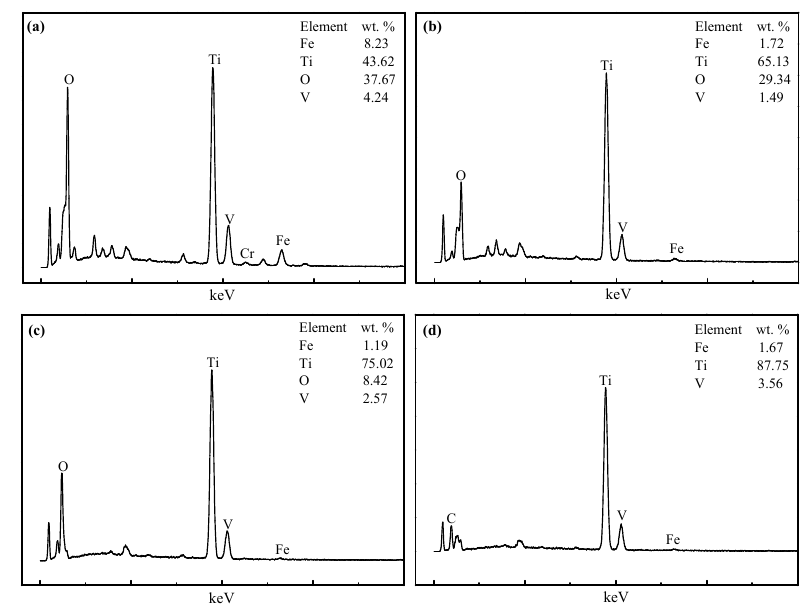
Figure 6. EDS analysis of different light grey areas: ( a ) area A; ( b ) area B; ( c ) area E; and ( d ) area F.